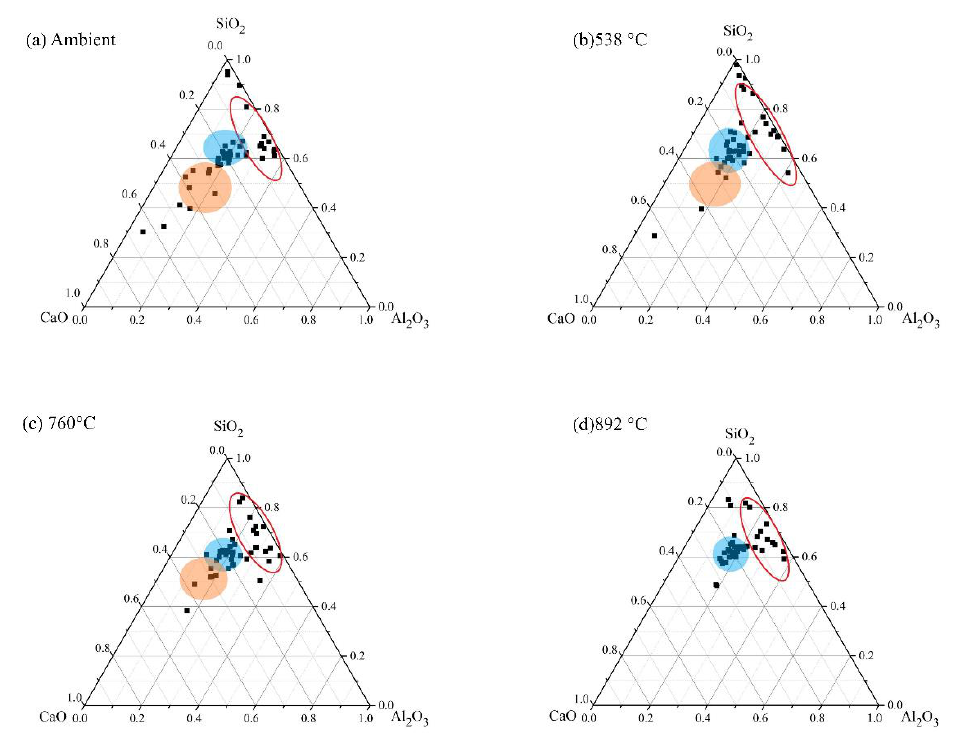
Figure 23. Ternary representation of EDS data for FS 50P-1.4 exposed to high temperatures.